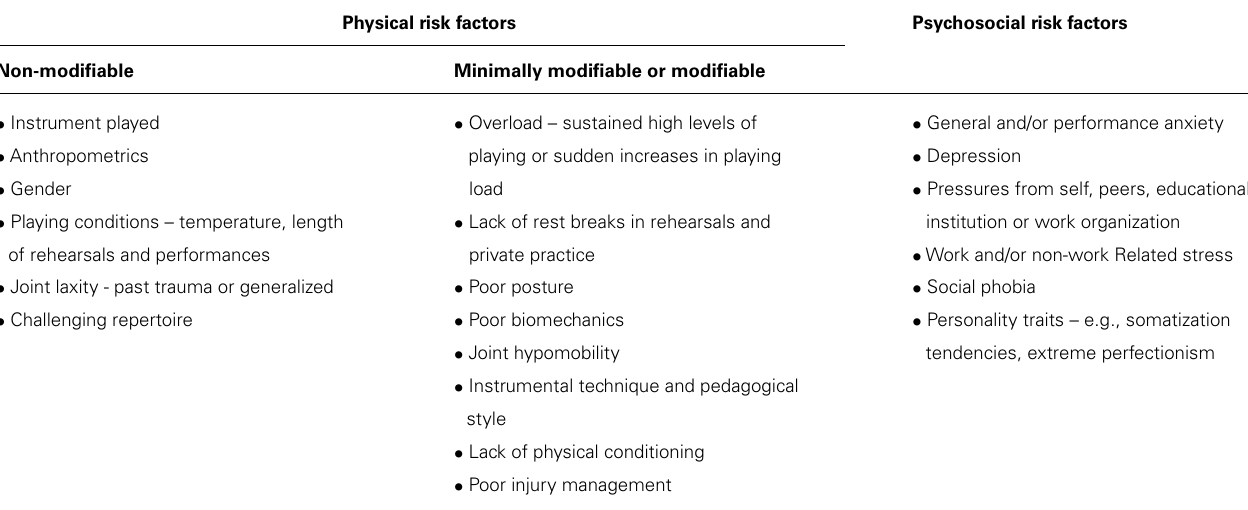
Table 1 | Physical and psychosocial factors influencing the development and perpetuation of performance-related musculoskeletal disorders (based onWu, 2007;Altenmüller and Jabusch, 2010; Brandfonbrener, 2010; Leaver etal., 2011;Ackermann etal., 2012; Kenny andAckermann,